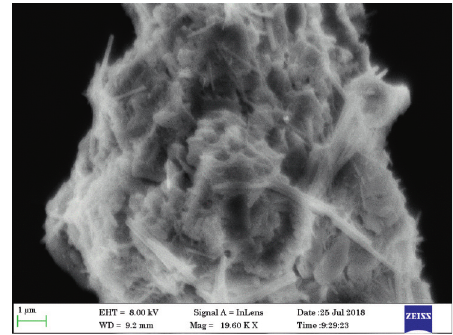
Figure 8: Micrograph of the optimum